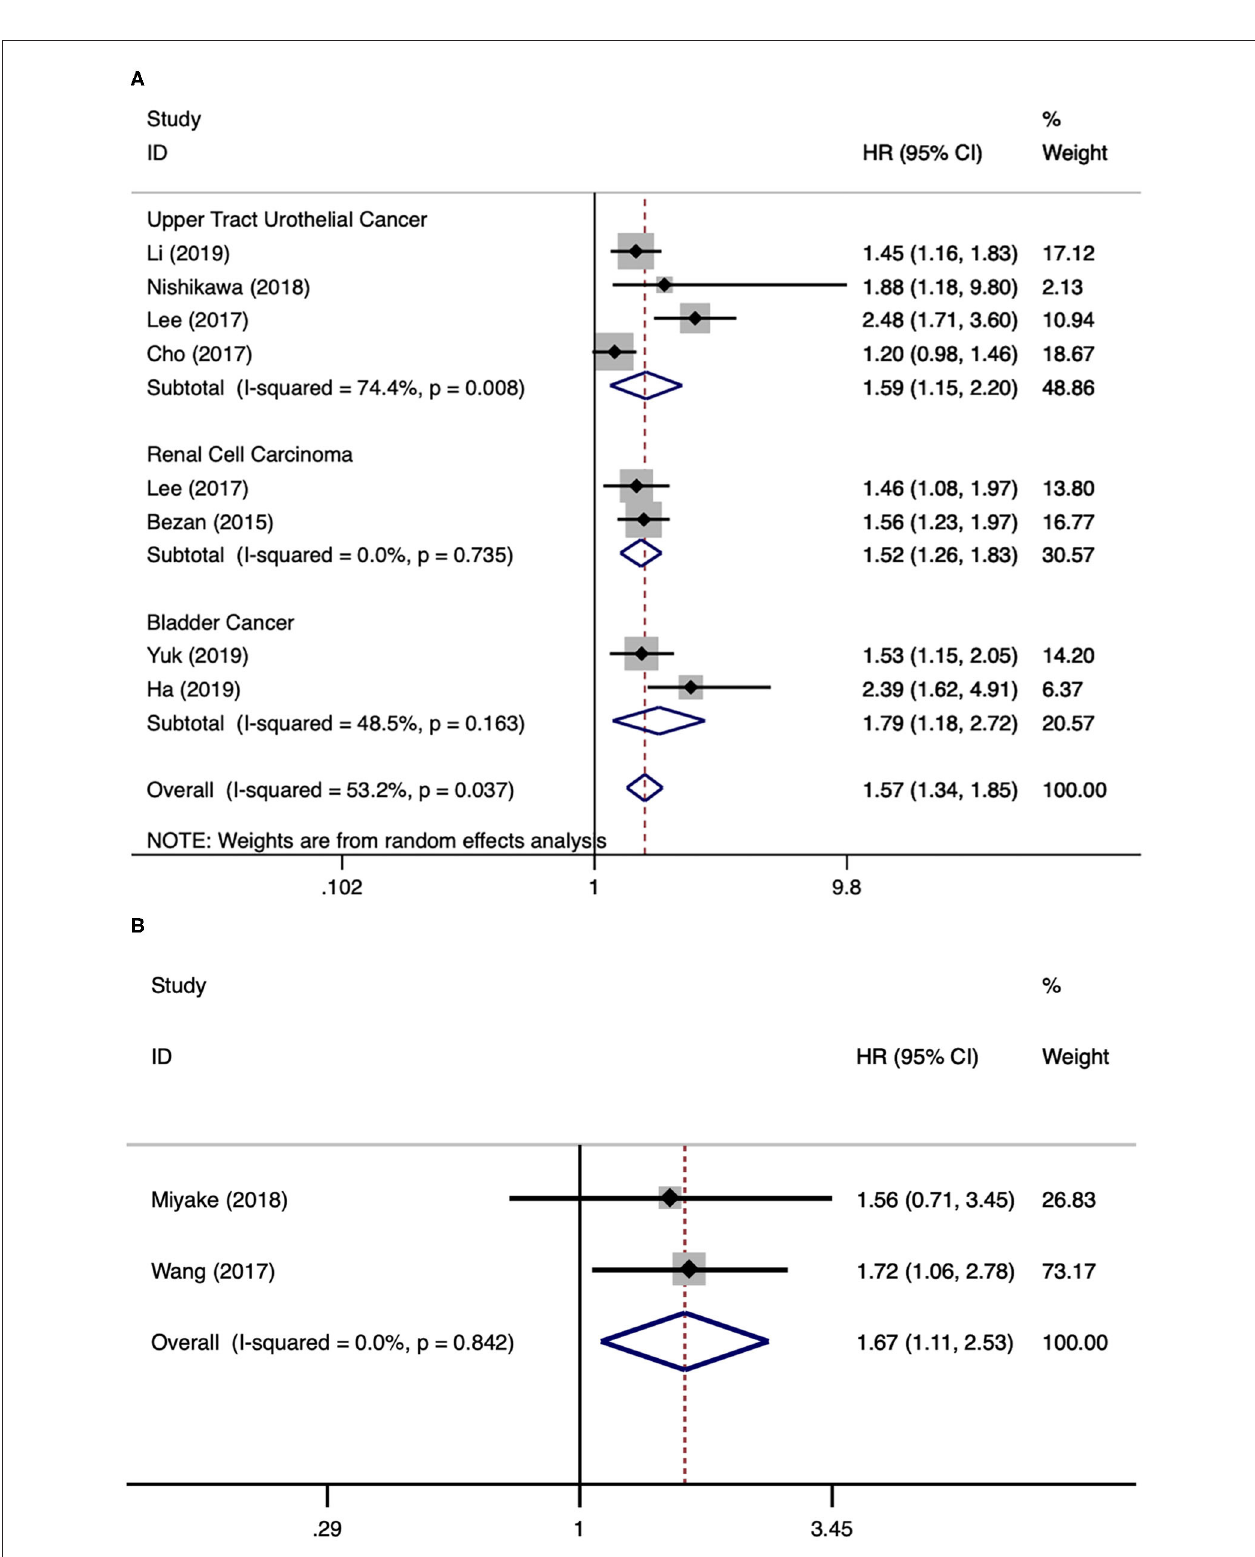
FIGURE 3 | Forest plot reflects the association between De Ritis ratio and PFS/BRFS for urological cancers. (A) De Ritis ratio and PFS; (B) De Ritis ratio and BRFS.